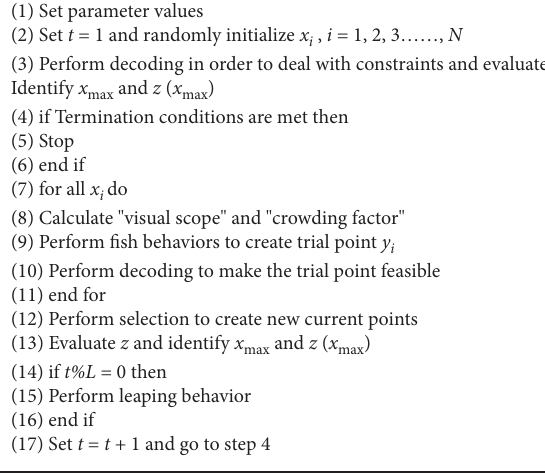
Figure 9: The binary version of the AFSA search